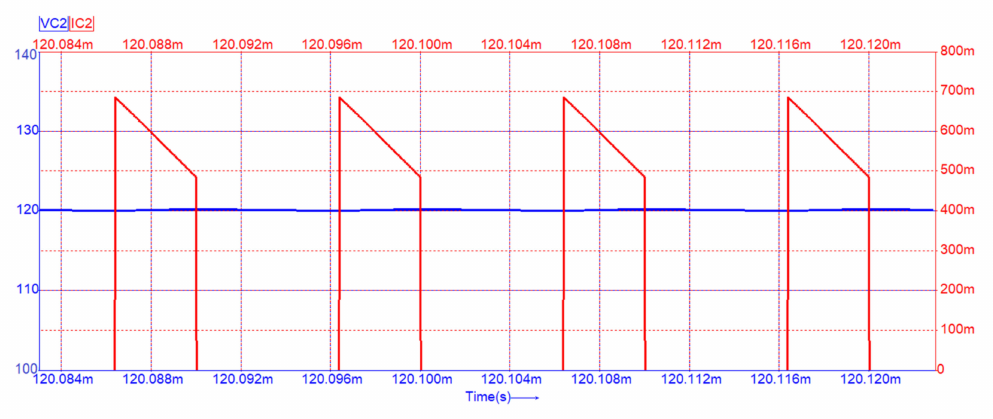
Figure 14. Voltage and current for the output capacitor C 2 .